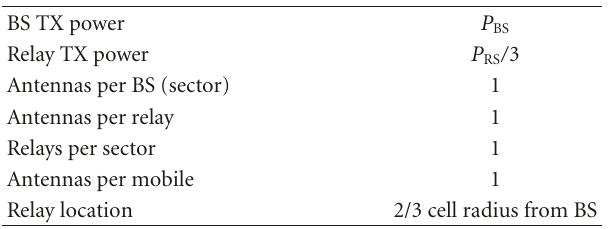
Table 1: System parameters for one-way relay model. The main di ff erences between the one-way relay model and the shared relay are the number of antennas per relay, the relay transmit power, and the number of relays per sector. Since over a large network there will be approximately 3 times as many relays for the one-way model than the shared relay model, they are given 1/3 the transmission power and 1/3 the antennas.